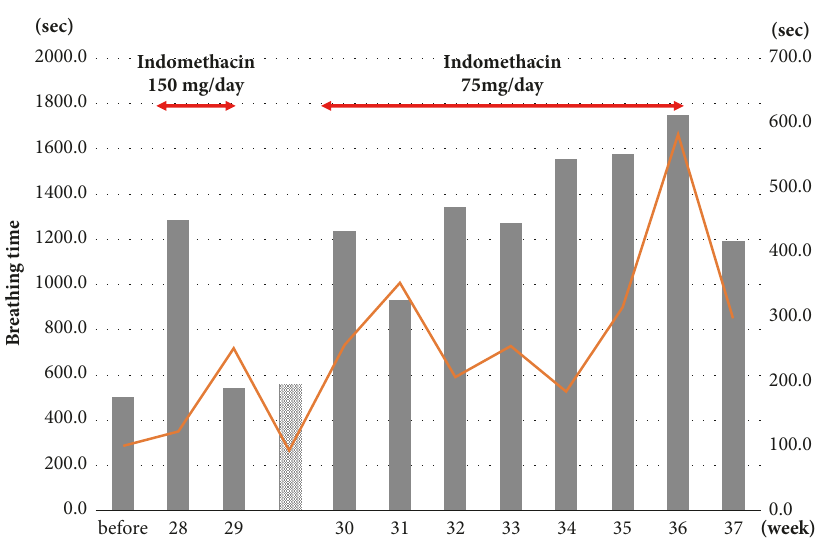
Figure 2: Breathing time (sec). The data are weekly averages. The left vertical scale is the total breathing time (shown in the black bar) in 30min. The right vertical scale is each average breathing time (the orange line). The data in the gray bar are corrected at 29 weeks and 6 days of